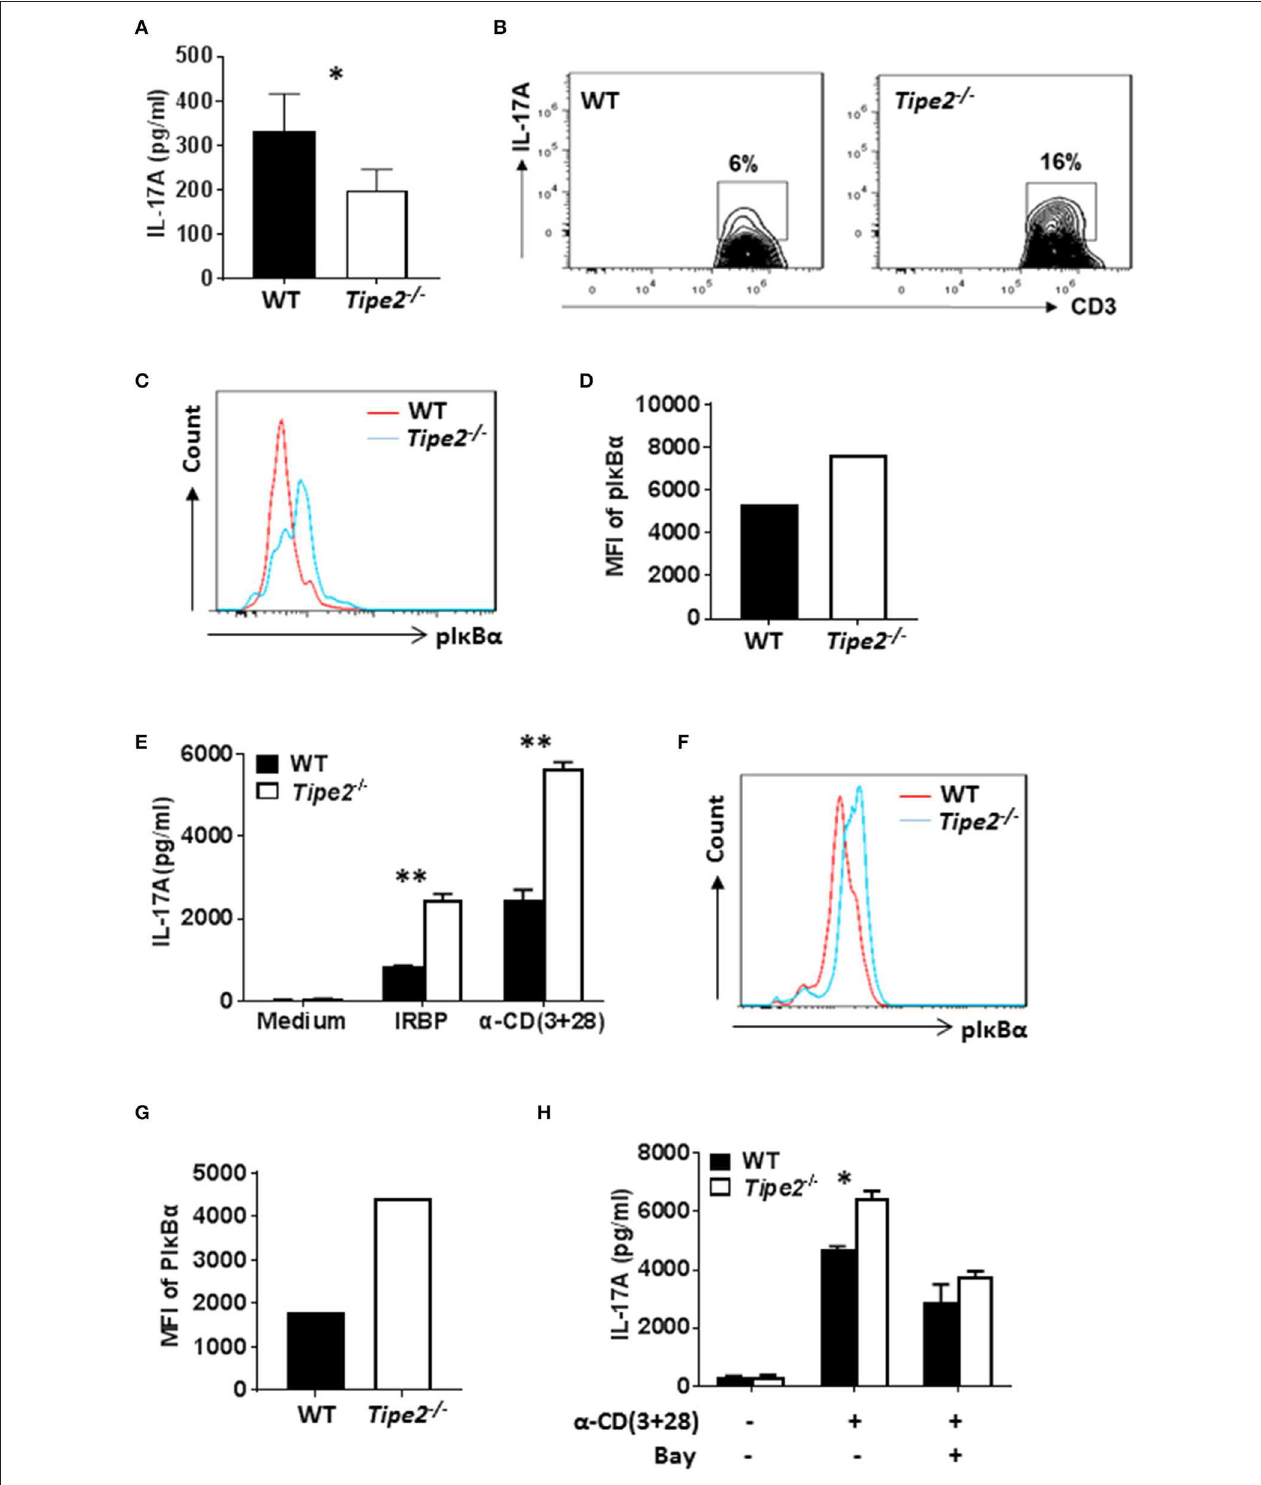
FIGURE 3 | The production of IL-17A is decreased in the skin but increased in the eye of TIPE2-deficient mice. (A–D) WT ( n = 5) and TIPE2-deficient ( n = 5) mice were treated as in Figure 1A and killed 3 days after the first IMQ treatment. (A) Tissue extracts were prepared from the back skin and the concentration of IL-17A in the tissue extract was determined by ELISA. (B) Total cells from the back skin were isolated and stimulated in vitro with PMA + ionomycin in the presence of GolgiStop